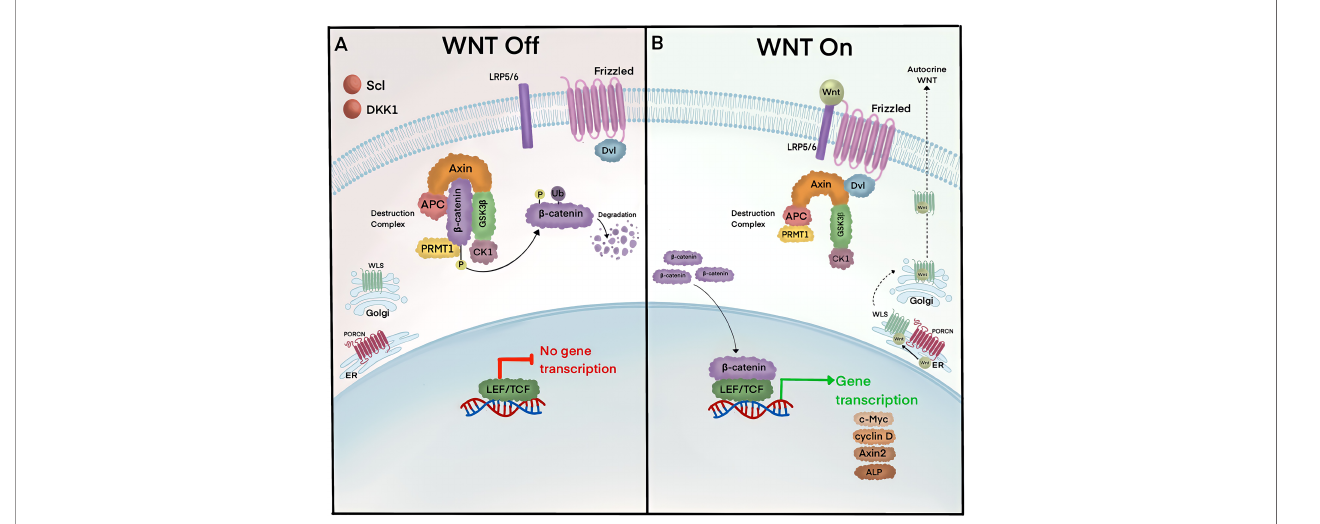
FIGURE 1 | ß-catenin lies at the heart of the canonical Wnt signaling pathway. (A) In the absence of the Wnt ligands, Axin, APC, and GSK3 form the ß-catenin destruction complex. Axin serves as a scaffold for APC and GSK3, which bind and phosphorylate cytoplasmic ß-catenin, respectively. Phosphorylated ß-catenin is ubiquitinated by ß-TrCP and targeted for degradation in proteasomes. (B) Pathway activity is initiated by Wnt ligands that are secreted by neighboring cells. Wnt ligands are produced in the ER and become palmitoylated by Porcupine (PORCN) receptors, which in turn translocate Wnt ligands into the Golgi for endosomal exocytosis. Extracellular Wnt ligands bind to receptors Fz and LRP5/6 and trigger the removal of destruction complexes and Protein Arginine Methyltransferase 1 (PRMT1) from the cytosol to stabilize ß-catenin. Accumulated ß-catenin translocate into the nucleus and binds to LEF/TCF and induces gene transcription of targets such as c-Myc, cyclin D, Axin2, and alkaline phosphatase (ALP). Pathway activity is turned off by multiple mechanisms, including negative feedback inhibition whereby ß-catenin induces gene transcription of secreted Wnt inhibitors, sclerostin (Scl) and Dickopff 1